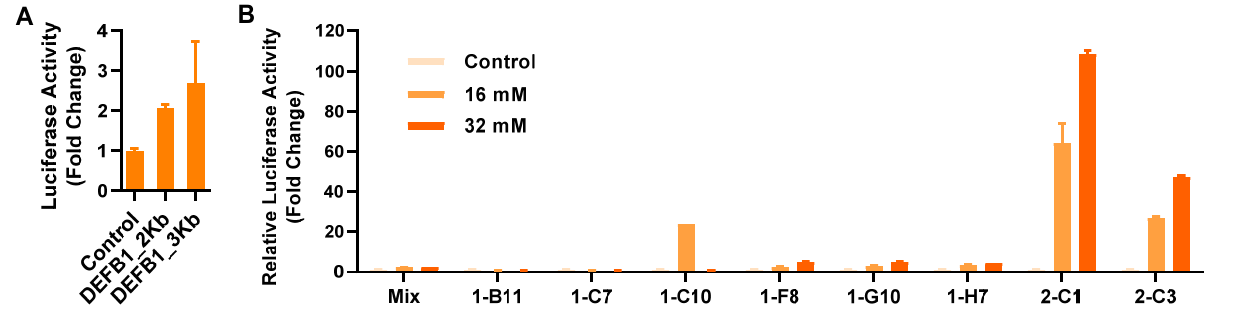
Figure 1. Establishment of stable HT-29/ DEFB1-luc reporter cell lines. ( A ) Fold changes in the relative luciferase activity of two DEFB1 gene promoter constructs following transient transfection into HT-29 cells in response to 2 mM sodium butyrate for 24 h. ( B ) Fold changes in the relative luciferase activity of individual clones of stable HT-29/ DEFB1-luc reporter cells stimulated with or without 16 or 32 mM butyrate for 24 h, relative to the nonstimulated control. The results are means ± SEM of 2–3 independent experiments.